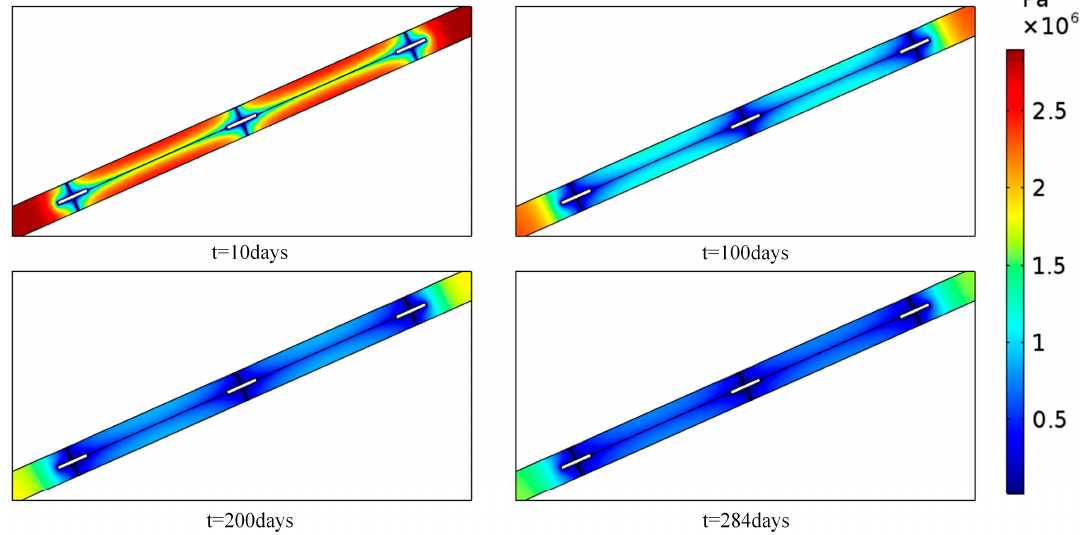
Figure 6. Gas pressure distribution of the matrix at different times.